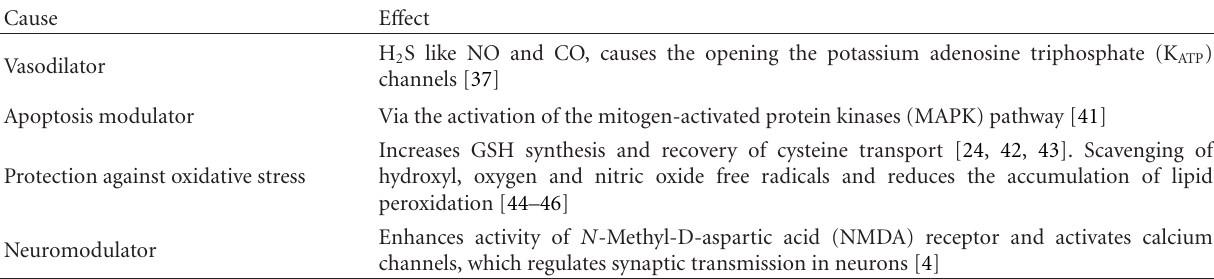
Table 1: E ff ects of H 2